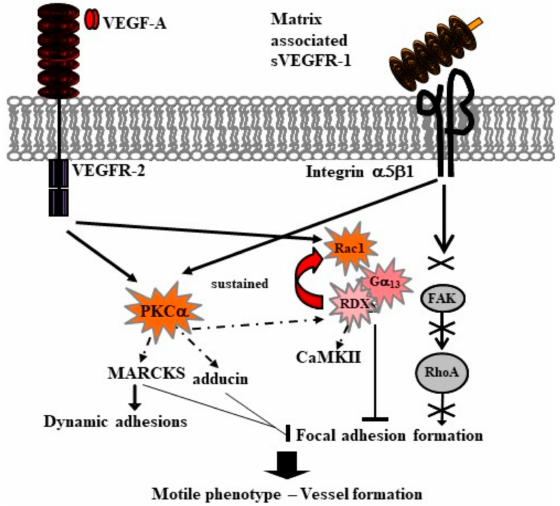
Figure 3. Molecular signals of motility are activated by endothelial cell adhesion to matrix sVEGFR-1 through α 5 β 1 integrin. Protein kinase C alpha (PKC α ) phosphorylation by VEGFR-2 and/or α 5 β 1 integrin (arrows) modulates both expression and phosphorylation (dotted arrow) of its